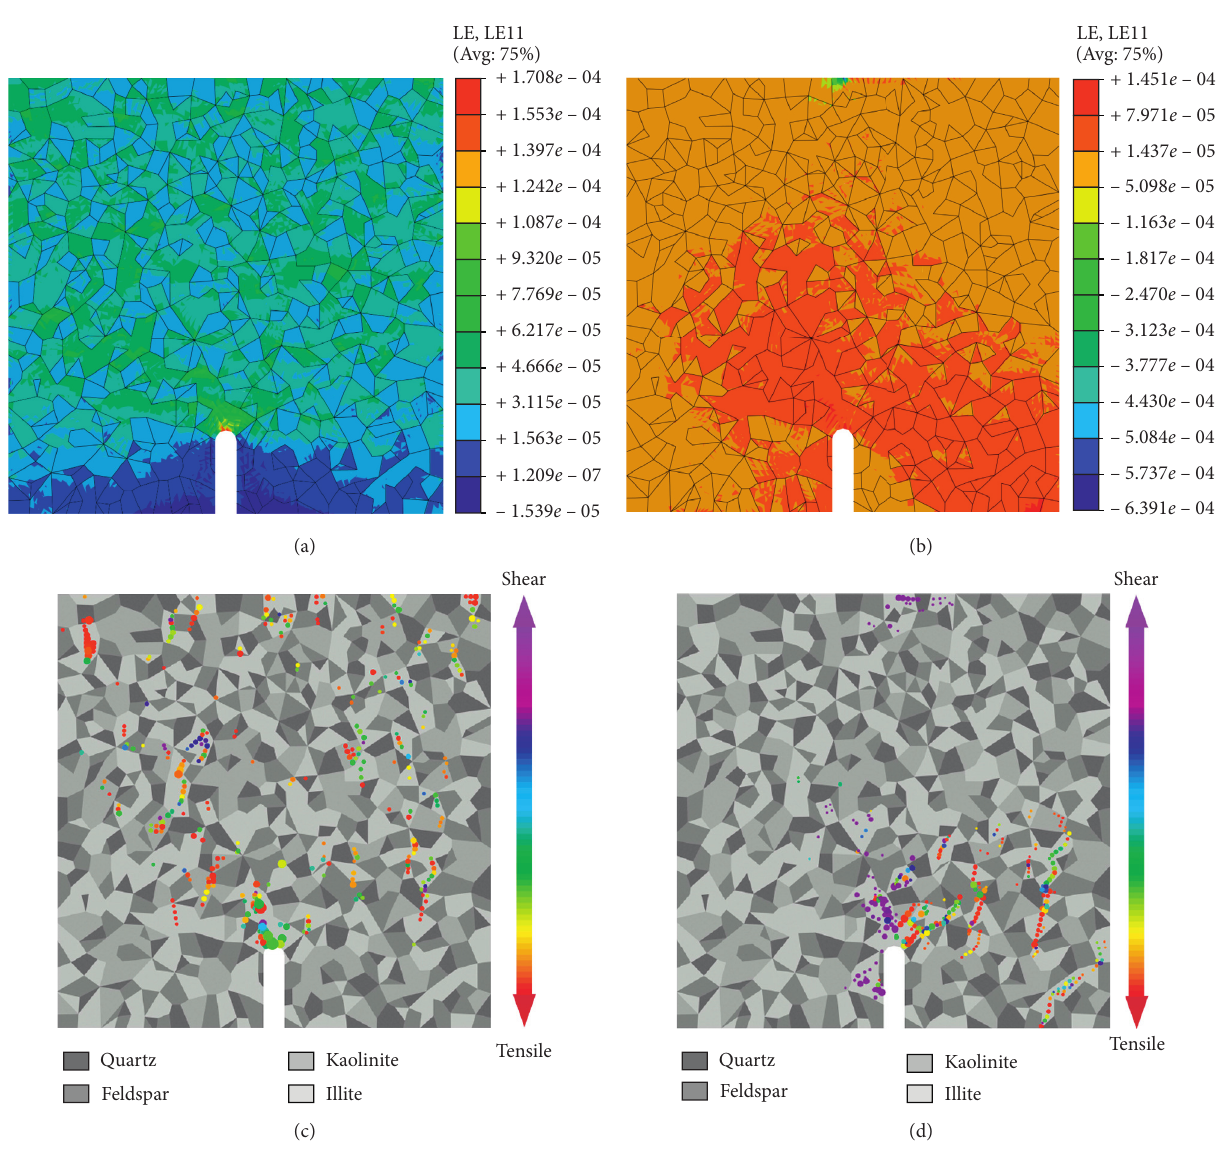
Figure 8: In loading method I (tensile loading) and loading method IV (shear loading), the strain and microfracture before the formation of macro-cracks. (a, b) Strain contour before macro-crack formation in loading methods I and IV, respectively. (c, d) In loading methods I and IV, the AE location of the microcracks distributed in the rock before the macrocrack formed. Red dots are the AE location of tensile fractures, purple dots are the AE location of shear fractures, and the colors between the two are the AE location of tensile-shear fractures. The size of the dot represents the level of AE energy. The AE energy of microfracture before the macrocrack formed is relatively small, so the AE energy magnification of this figure is larger than the others in this